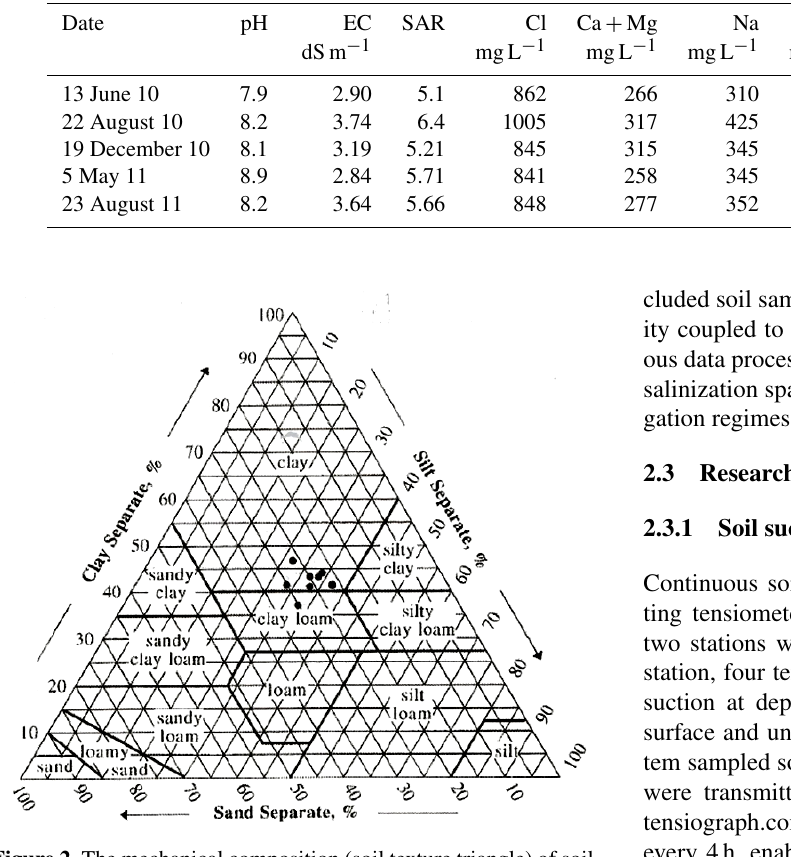
Figure 2. The mechanical composition (soil texture triangle) of soil at the research site. The depth range of the travertine layer is from 110cm at the southern edge to 55–60cm at the northern edge of the site (Fig.